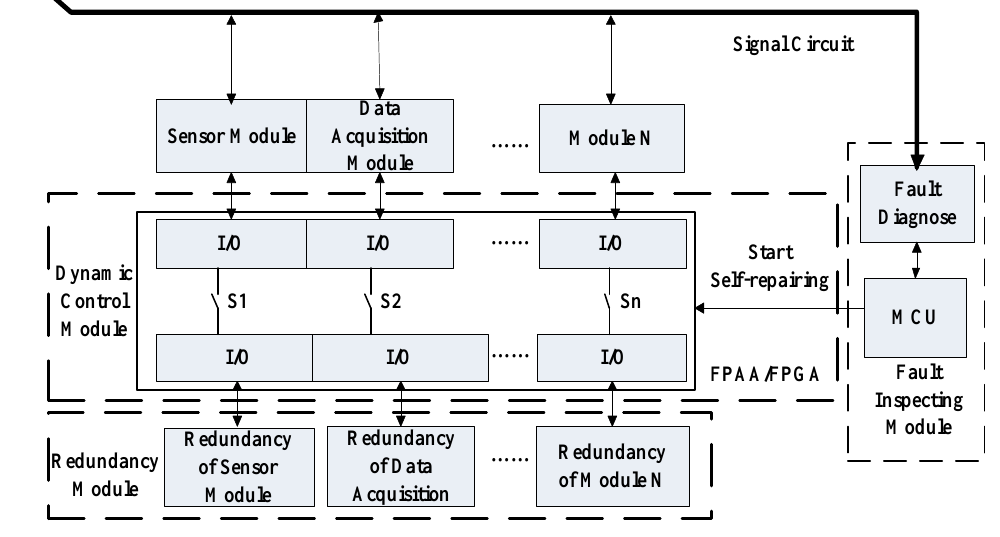
Figure 2. FPGA/FPAA-based self-healing WSN node design